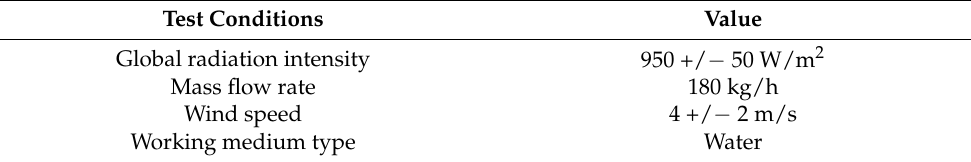
Table 3. Outdoor conditions during the thermal efficiency characteristic η c measurements.